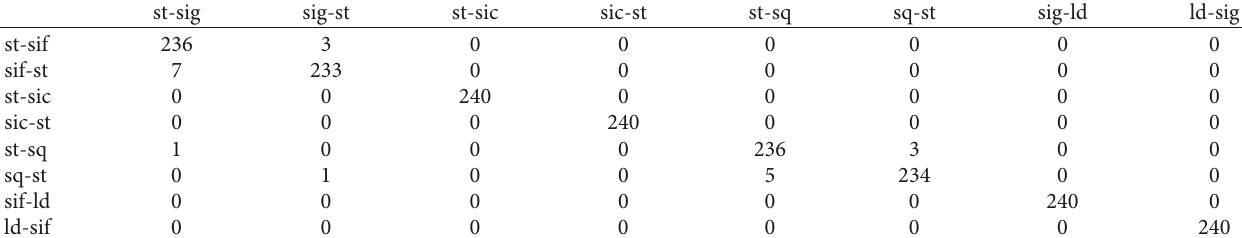
Table 6: Recognition results of each posture transition under DPK-OMELM.